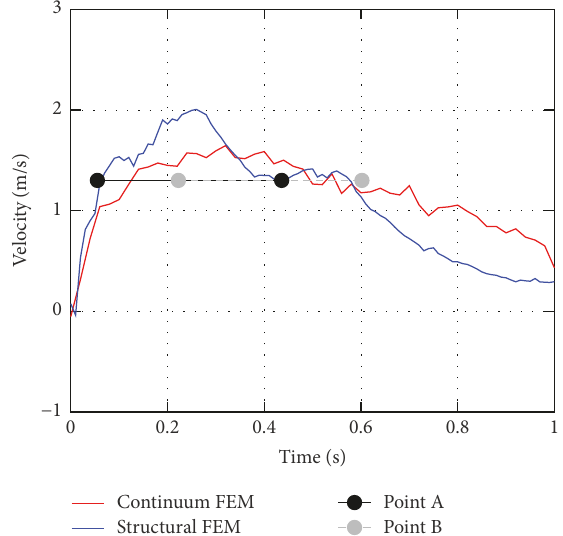
Figure 7: Stress-strain diagram for 25 MPa EC2 material model. Unconfined uniaxial tension and compression. Material model without homogeneous steel reinforcement and with 1% of steel reinforcement.